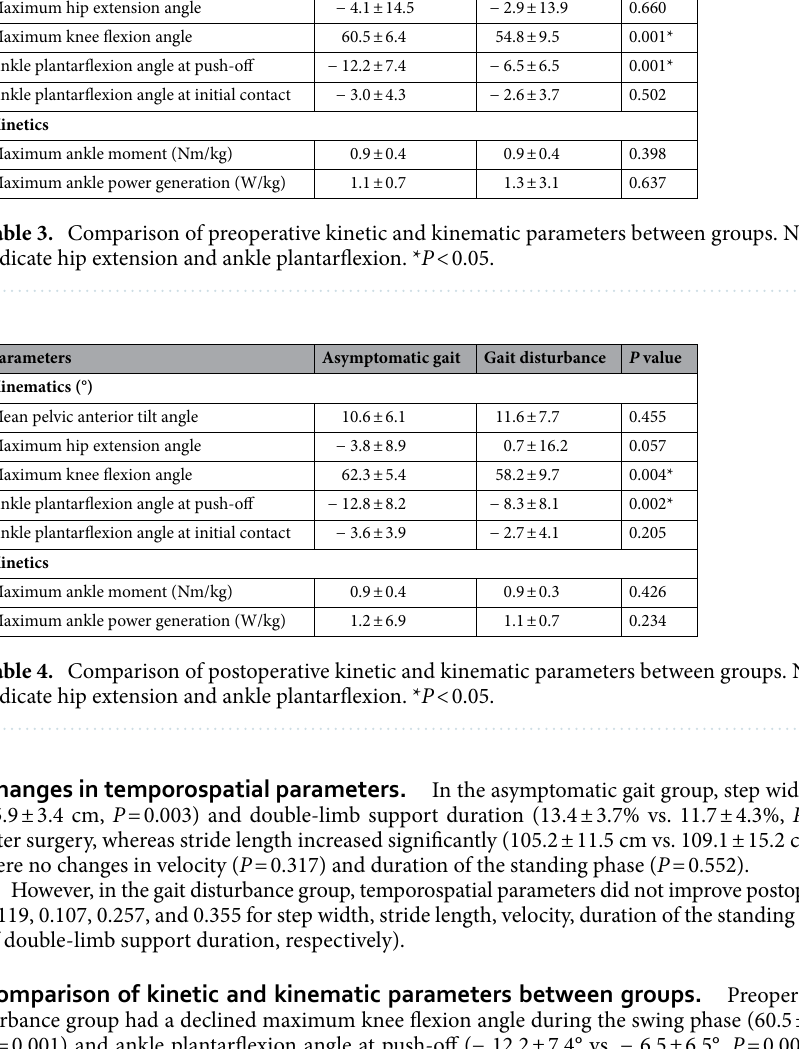
Changes in temporospatial parameters. In the asymptomatic gait group, step width (17.2 ± 3.4 cm vs. 15.9 ± 3.4 cm, P = 0.003) and double-limb support duration (13.4 ± 3.7% vs. 11.7 ± 4.3%, P = 0.027) decreased after surgery, whereas stride length increased significantly (105.2 ± 11.5 cm vs. 109.1 ± 15.2 cm, P = 0.015). There were no changes in velocity ( P = 0.317) and duration of the standing phase ( P = 0.552). However, in the gait disturbance group, temporospatial parameters did not improve postoperatively ( P = 0.225, 0.119, 0.107, 0.257, and 0.355 for step width, stride length, velocity, duration of the standing phase, and duration of double-limb support duration, respectively). Comparison of kinetic and kinematic parameters between groups. Preoperatively, the gait dis- turbance group had a declined maximum knee flexion angle during the swing phase (60.5 ± 6.4° vs. 54.8 ± 9.5°, P = 0.001) and ankle plantarflexion angle at push-off (− 12.2 ± 7.4° vs. − 6.5 ± 6.5°, P = 0.001) compared to the asymptomatic gait group (Table 3). After surgery, the gait disturbance group still demonstrated a less maximum knee flexion angle during the swing phase (62.3 ± 5.4° vs. 58.2 ± 9.7°, P = 0.004) and ankle plantarflexion angle at push-off (− 12.8 ± 8.2° vs. − 8.3 ± 8.1°, P = 0.002) compared to the asymptomatic gait group (Table 4). Changes in kinetic and kinematic parameters. In the asymptomatic gait group, there were no sig- nificant changes in the mean pelvic anterior tilt ( P = 0.066), maximum hip extension angle ( P = 0.625), maxi- mum knee flexion angle ( P = 0.062), maximum ankle moment ( P = 0.798), and maximum ankle power gen- eration ( P = 0.287). However, the ankle plantarflexion angle at push-off increased significantly (− 12.2 ± 7.4° vs. − 12.8 ± 8.2°, P = 0.042). In the gait disturbance group, the mean pelvic anterior tilt (9.9 ± 8.2° vs. 11.6 ± 7.7°, P = 0.028) increased and the maximum hip extension angle decreased (− 2.9 ± 13.9° vs. 0.7 ± 16.2°, P = 0.006) after surgery. The maximum